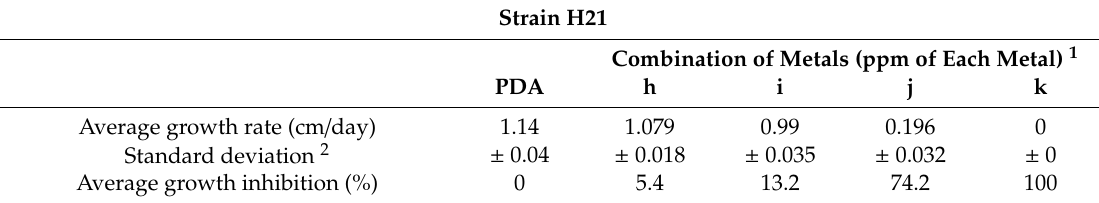
Table 4. Growth rate and percentage of growth inhibition of strain H21 in the presence of heavy metals combinations. Strain H21 Combination of metals (ppm of each metal) 1 PDA h i j k Average growth rate (cm/day) 1.14 Average growth inhibition (%)